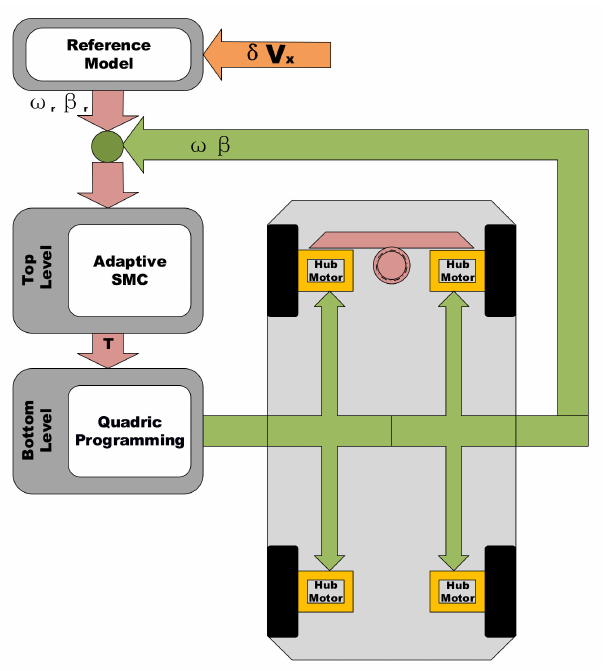
Figure 3. Block diagram of proposed